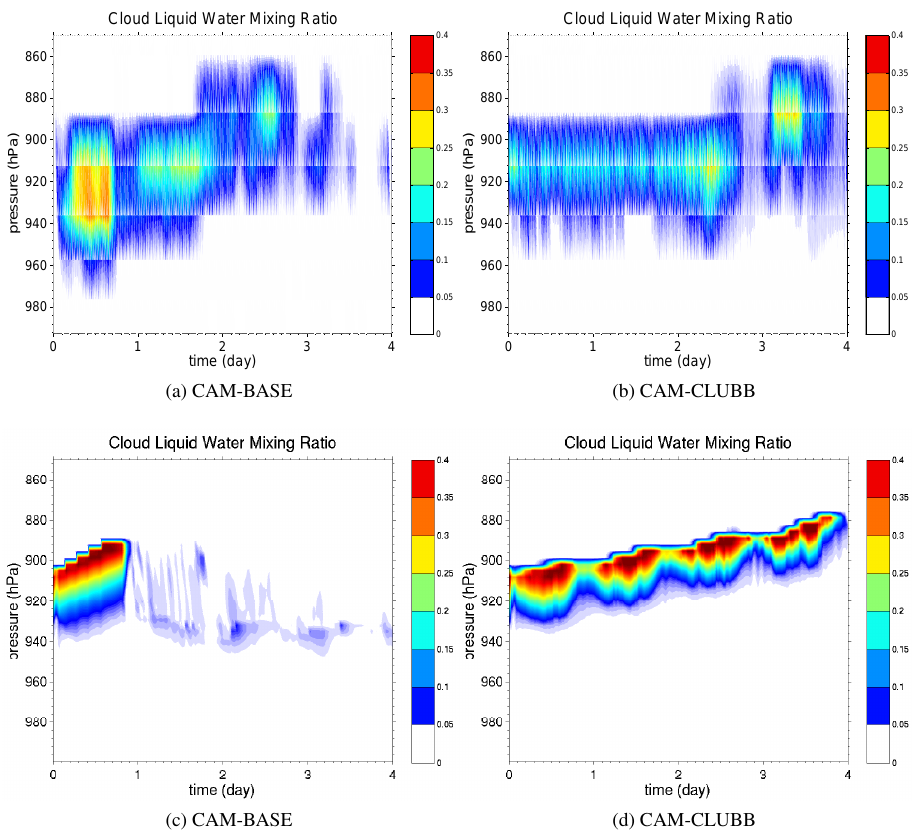
Fig. 10: Evolution of the cloud liquid water mixing ratio ( gkg (cid:0) 1 ) for CAM-BASE (a, c) and CAM-CLUBB (b, d) for the four Fig. 10. Evolution of the cloud liquid water mixing ratio (gkg − 1 ) for CAM-BASE (a, c) and CAM-CLUBB (b, d) for the four-day simulation day simulation of DYCOMS2-RF01 using 30 vertical levels and ∆ t =1800s (a, b) and 240 vertical levels and ∆ t =60s . of DYCOMS2-RF01 using 30 vertical levels and 1t = 1800s (a, b) and 240 vertical levels and 1t = 60s (c, d)